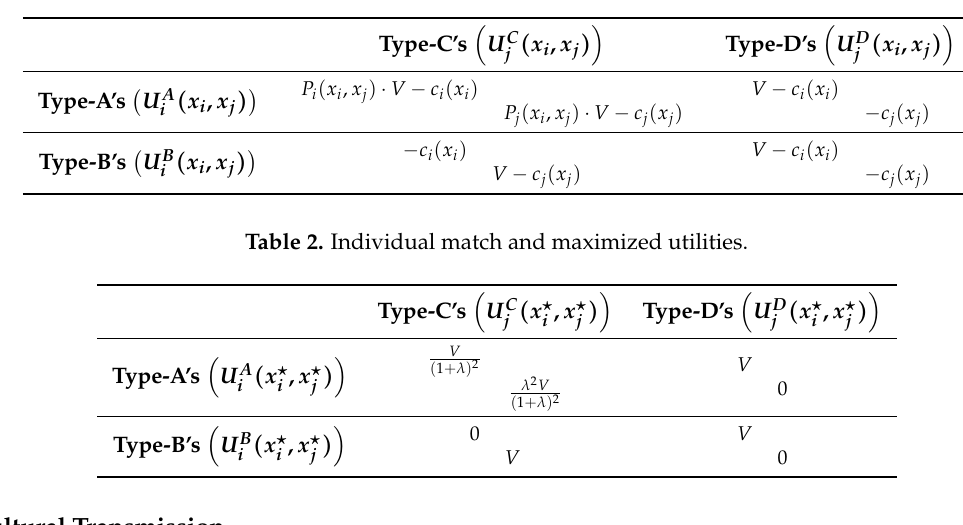
Table 1. Individual match and utility function.